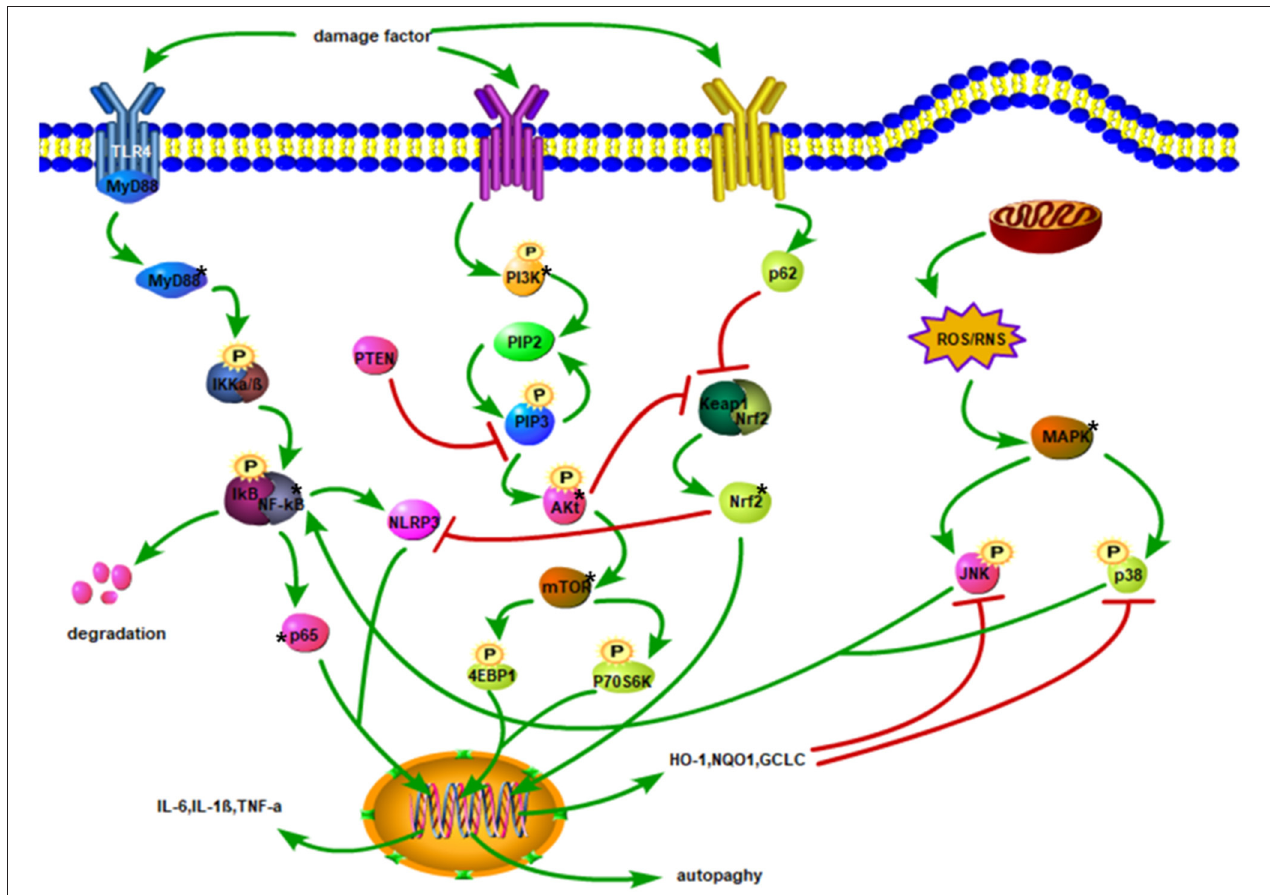
FIGURE 1 | Injury factors activate TLR4/MyD88 and promote IKK α / β phosphorylation. The degradation of I κ B facilitates the translocation of p65 of NF- κ B to the nucleus, thereby increasing the expression of inflammatory factors. Phosphorylation of PI3K triggers the conversion of PIP2 to PIP3 and stimulates Akt phosphorylation. Akt activates mTOR to phosphorylate 4EBP1, and P70S6K to enhance autophagy. Activated p62 may inhibit Keap1 and Nrf2 complexes, promote the release of Nrf2 into the cytoplasm, and then translocate to the nucleus. After Nrf2 enters the nucleus, it upregulates the expressions of HO-1, NQO1, and GCLC, leading to oxidation impairment and hindering the phosphorylation of JNK and p38. Phosphorylated JNK and p38 activate NF- κ B. Mitochondrial damage produces ROS and RNS, which activates the phosphorylation of JNK and p38 downstream of MAPK. The NF- κ B stimulates NLRP3, and Nrf2 inhibits NLRP3